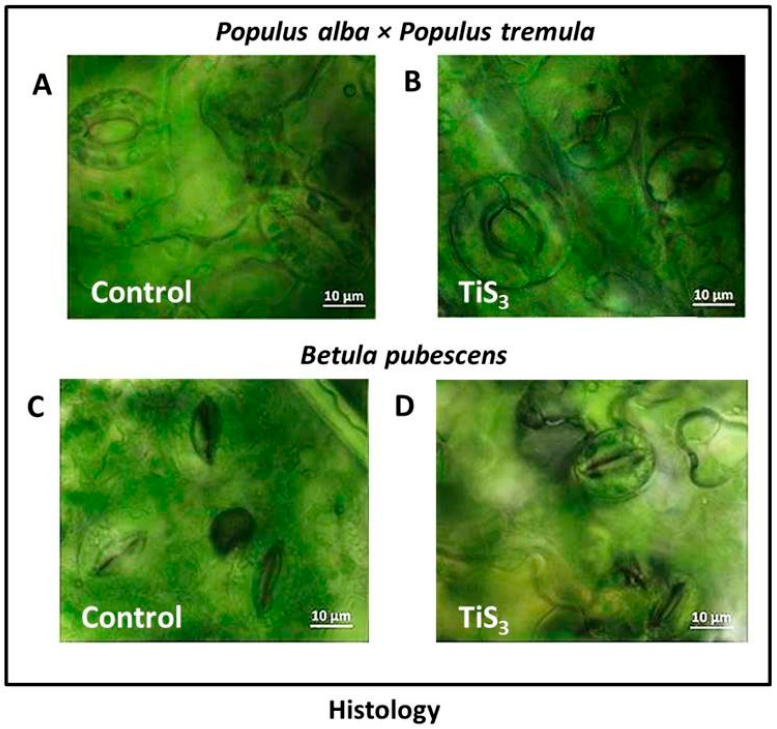
Figure 4. Stomata of the leaves of the studied plants. Hybrid poplar × aspen: ( A ) control, ( B ) TiS 3 ; Downy birch: ( C ) control, ( D ) TiS 3 .